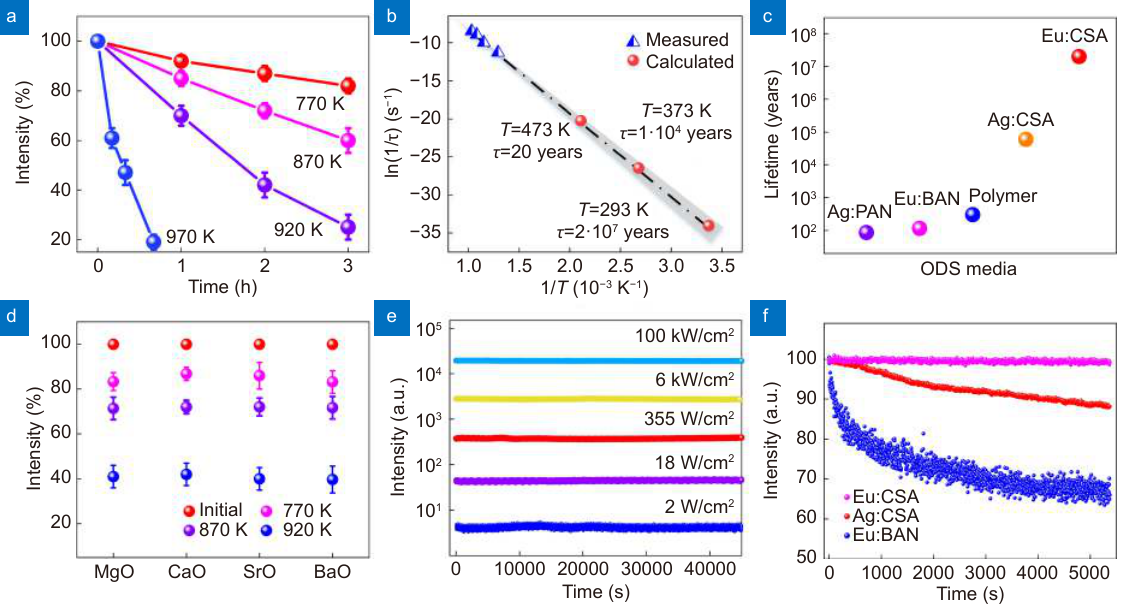
Fig. 4 | Stability of recorded information. ( a ) Thermal stability of PL in Eu: CSA glass. ( b ) Arrhenius plot of the decay rate. Grey area: error es- timates. ( c ) Comparison of lifetime in ODS based on different media 6,8 . ( d ) Comparison of thermostability of PL in Eu: DSA glasses. ( e ) PL stabil- ity of written dots under various excitation power densities. ( f ) PL stability of different ODS media.